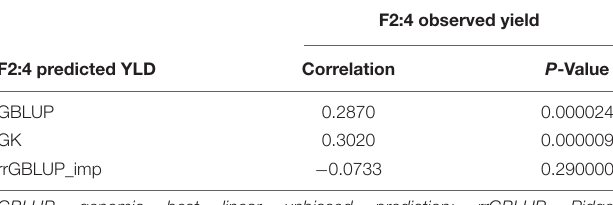
TABLE 6 | Experiment 2: Correlations between F2:4 GEBVs from three prediction methods (GBLUP, GK, and rrGBLUP_imp) from grain yield of 213 derived F2:4 lines across two